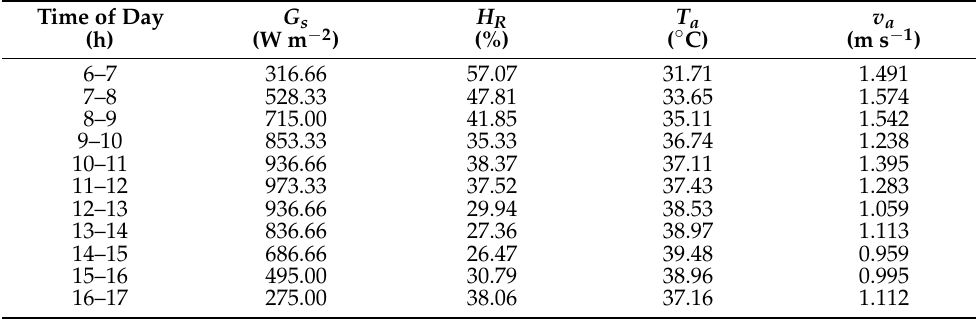
Table A2. Weather data set for the summer day (24 July 2018) used in the PVT-RO simulations. Time of Day (h)